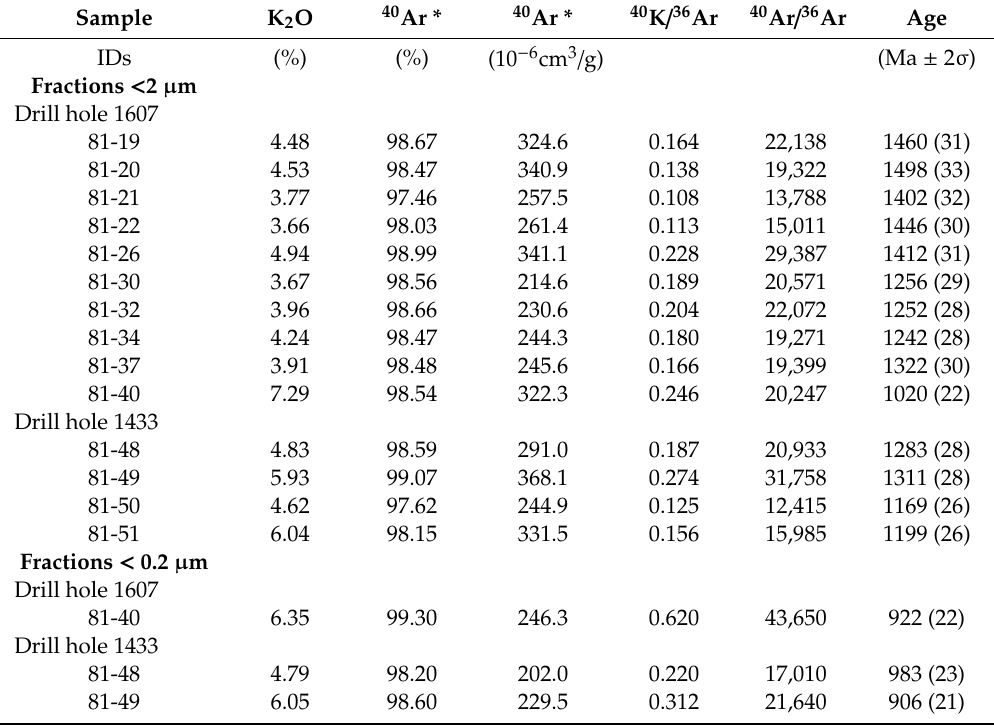
Table 2. K-Ar data of the previously studied < 2 µ m by Philippe et al. [22] and of the < 0.2 µ m illite-rich size fractions herein analyzed.